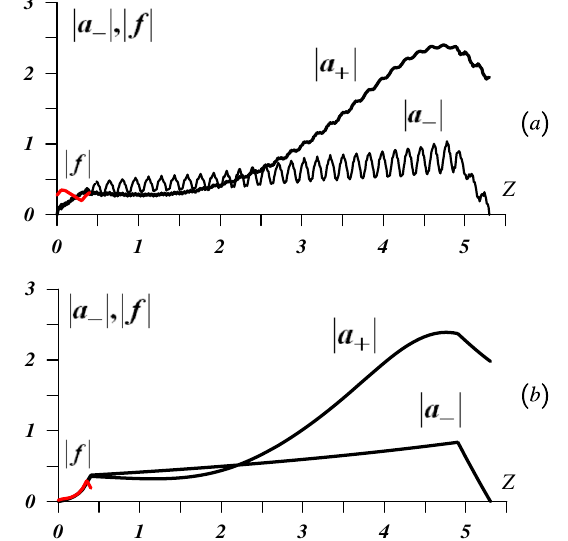
FIG. 5. Longitudinal distributions of partial waves a (cid:4) and f in the steady-state regime along the resonator axis Y ¼ B= 2 at the moderate oversize factor B ¼ 1 (a) and similar curves obtained using the simplified model (19) and (20) with the fixed trans- ¼ 0 : 4 , L 0 ¼ 4 , verse structures of propagating waves (b) ( L 1 ; 2 (cid:4) 1 ¼ 4 , (cid:4) 2 ¼ 1 , (cid:2) ¼ (cid:2) 0 : 5 , C (cid:1) 1 : 4 (cid:10) 10 (cid:2) 4 ).